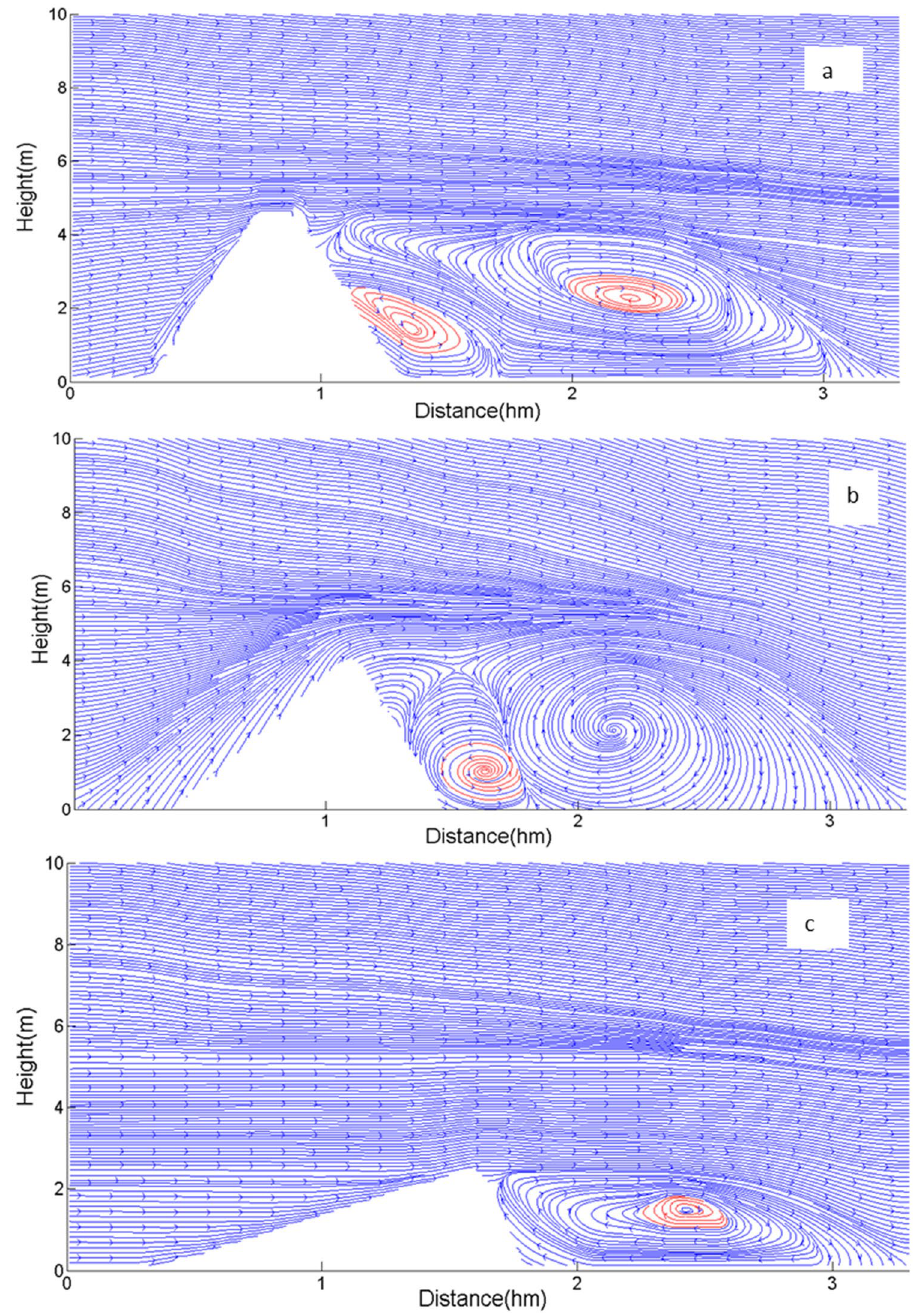
Figure 3. Distributions of two-dimensional wind flow field around the crescentic dune in Fig. 1a ( a ), 1b ( b ) and 1d ( c ) (red circles represented the